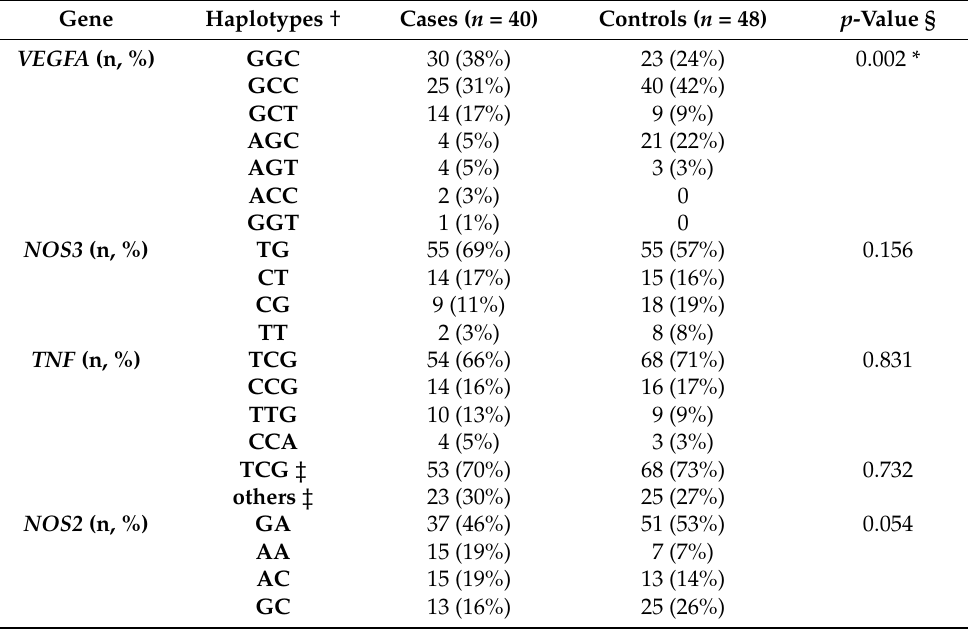
Table 3. Frequencies of the haplotypes generated by the combination of alleles of the polymorphisms in VEGFA, NOS3, TNF, and NOS2 genes in case and control groups.